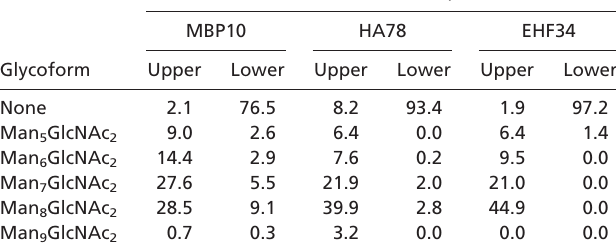
Table 2. LC-ESI-MS analysis of the glycosylated Fc peptides EEQYN 297 STYR and TKPREEQYN 297 STYR from scFv-Fc-producing Arabidopsis